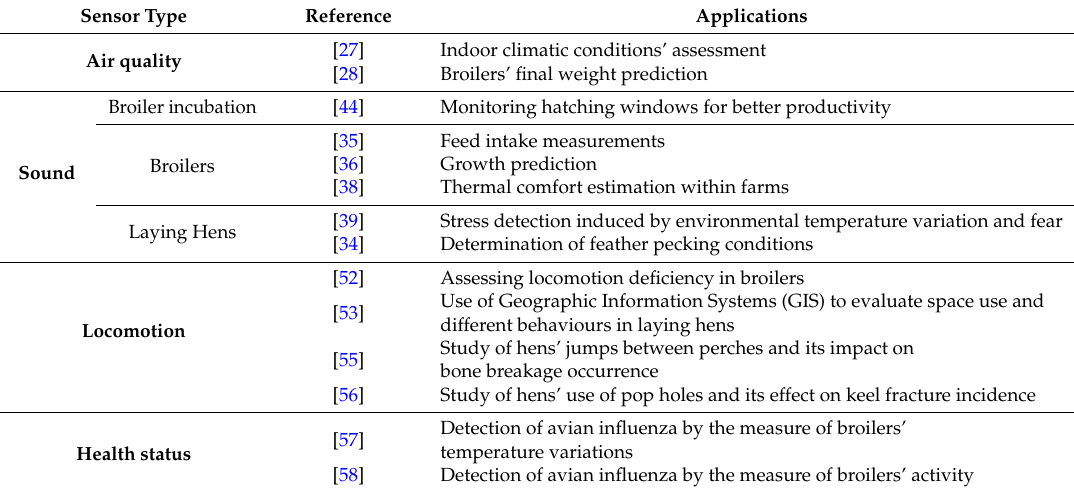
Table 1. Main sensor technologies and potential applications to improve poultry